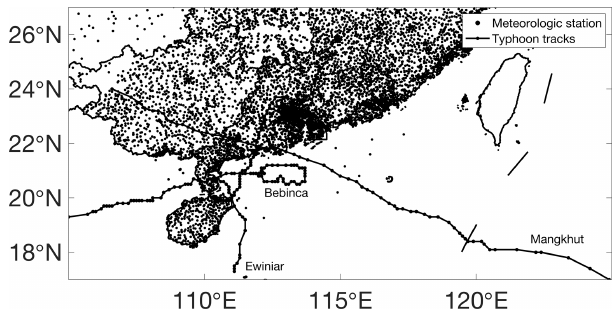
Figure 1. Distribution of high-density ground rain-gauge stations over the study